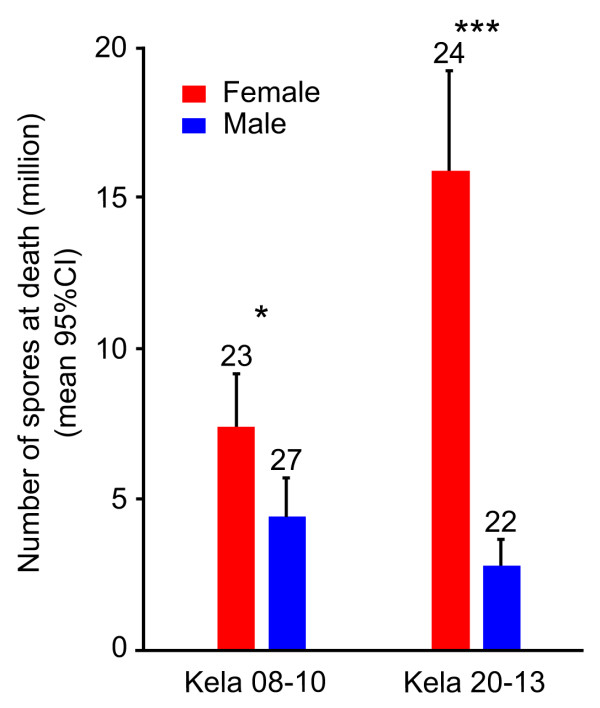
Number of spores at death in male and female hosts. P. ramosa had higher fitness in females than in males in both Daphnia (Experiment 2, Kruskal-Wallis rank test, Clone Kela-08-10: df = 1, χ2 = 6.2, P = 0.01; Clone Kela-20-13: df = 1, χ2 = 32.1, P < 0.00001). Error bars are 95% confidence intervals.